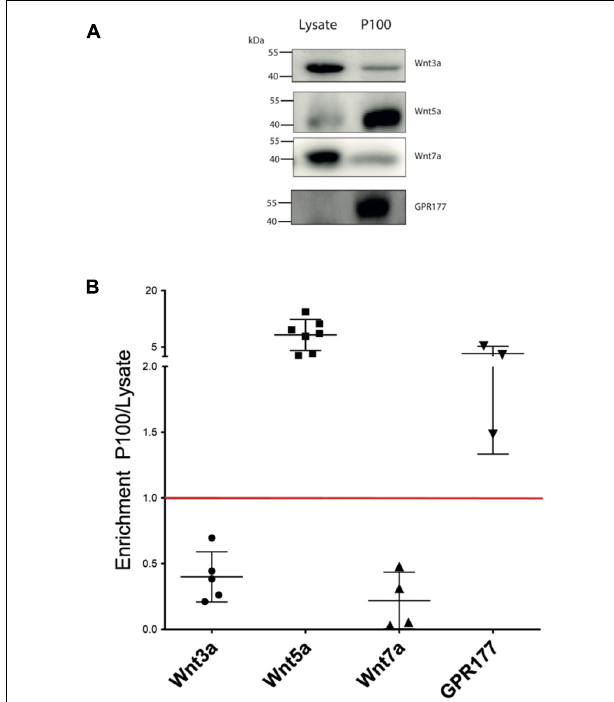
FIGURE 2 | Wnt ligand expression levels in HT-22 cells. (A) Comparison of western blot analysis of Wnt3a, Wnt5a, Wnt7a, and GPR177 protein content in cell lysate and P100 fraction. Each lane was loaded with 30 µ g protein. (B) Summary densitometric measurement of band intensity showing enrichment (fold) of each protein in the P100 pellet relative to a corresponding lysate. Wnt3a, 0.4 ± 0.19 ( n = 5); Wnt5a, 8.70 ± 4.14 ( n = 7); Wnt7a, 0.22 ± 0.21 ( n = 4; four independent cell culture preparations); GPR177 3.30 ± 1.93 ( n = 3; independent cell culture